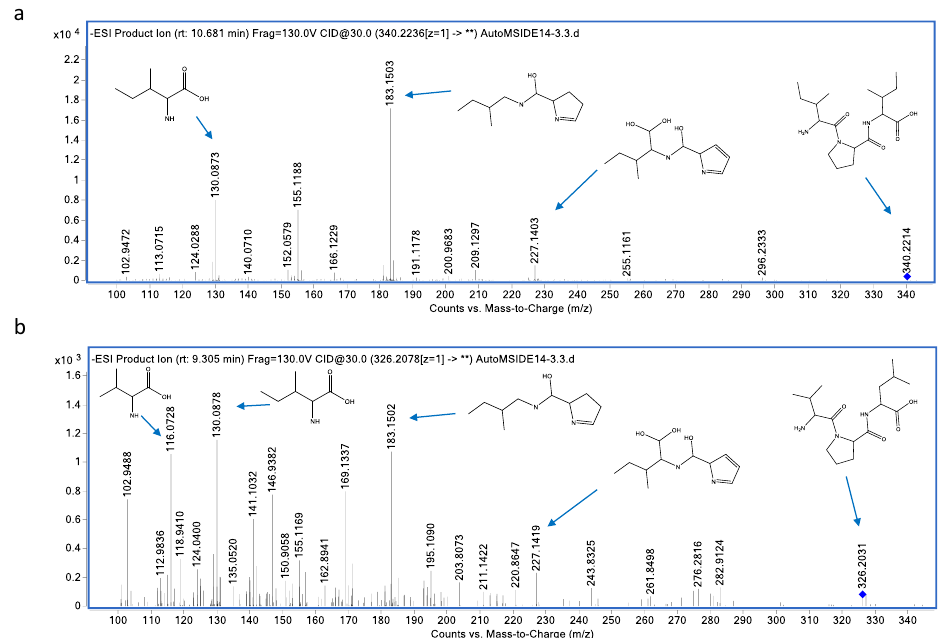
Figure 5. MS/MS fragmentation spectra plot of diprotin A (Ile-Pro-Ile) and diprotin B (Val-Pro-Leu) at 30 ev of collision energy. ( a ) MS/MS fragmentation spectra of diprotin A; ( b ) MS/MS fragmentation spectra of diprotin B.